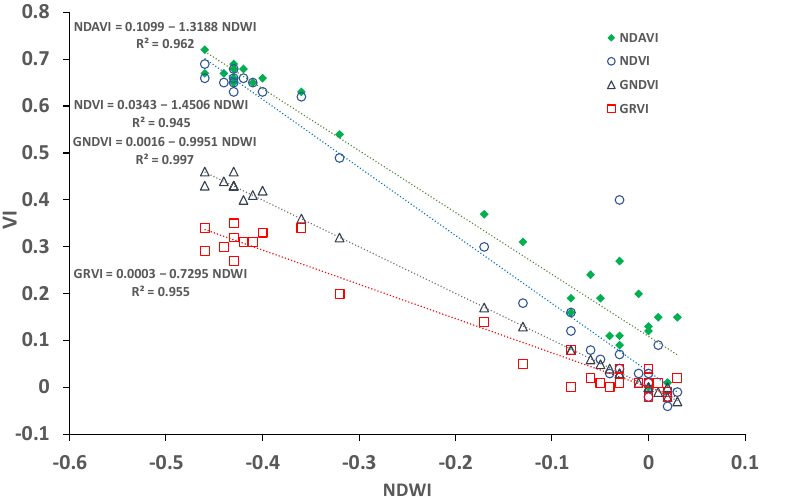
Figure 8. Relationship between the NDWI and NDAVI, NDVI, GNDVI, and GRVI. The indices were calculated from Sentinel-2 data at 10 m spatial resolution, for the period 6 June–6 October 2021, for assessing the presence of duckweeds in a section of the Lis River (Portugal). The sample includes data from three observed areas defined on the river water surface (Figure 4a).